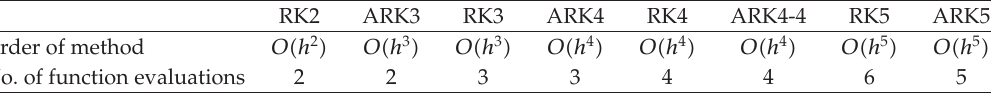
Table 6: Summary of order and number of function evaluations per time step for RK methods and ARK methods presented